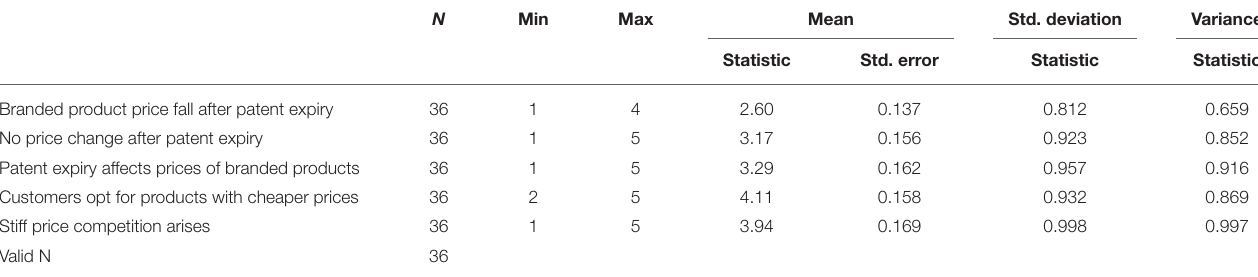
TABLE 3 | Changes in price descriptive